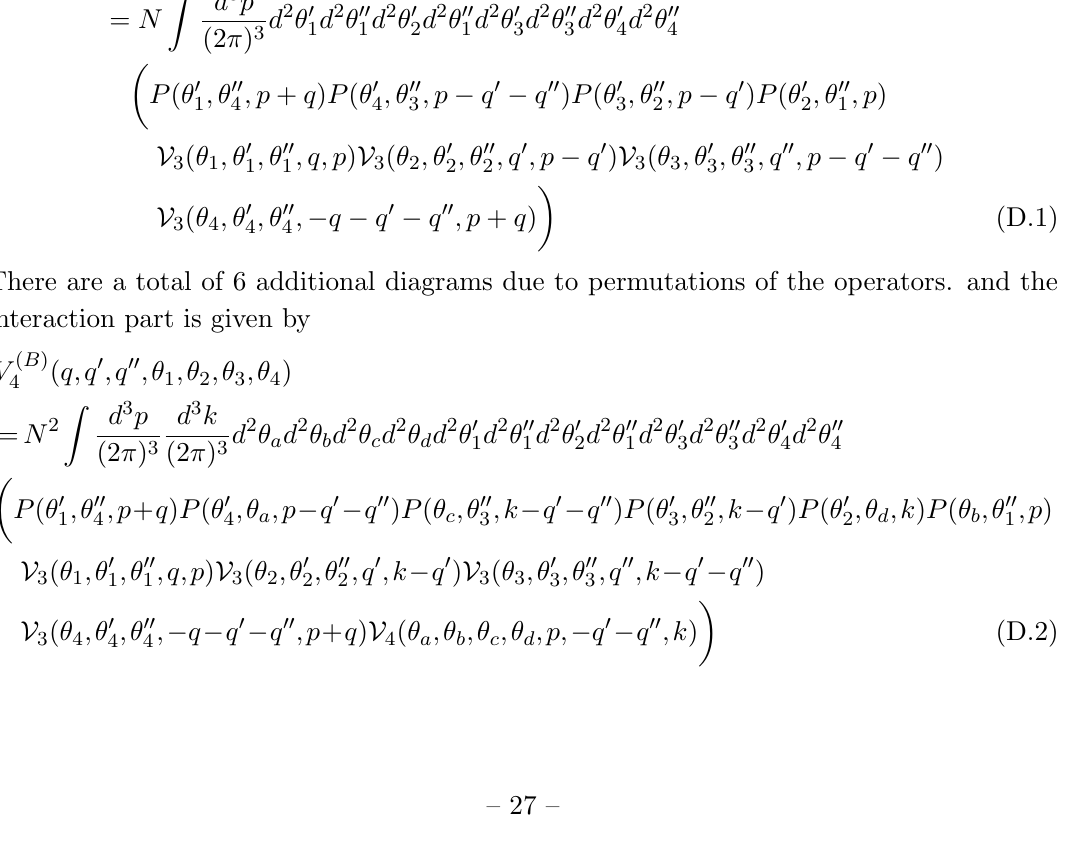
JHEP04(2020)207